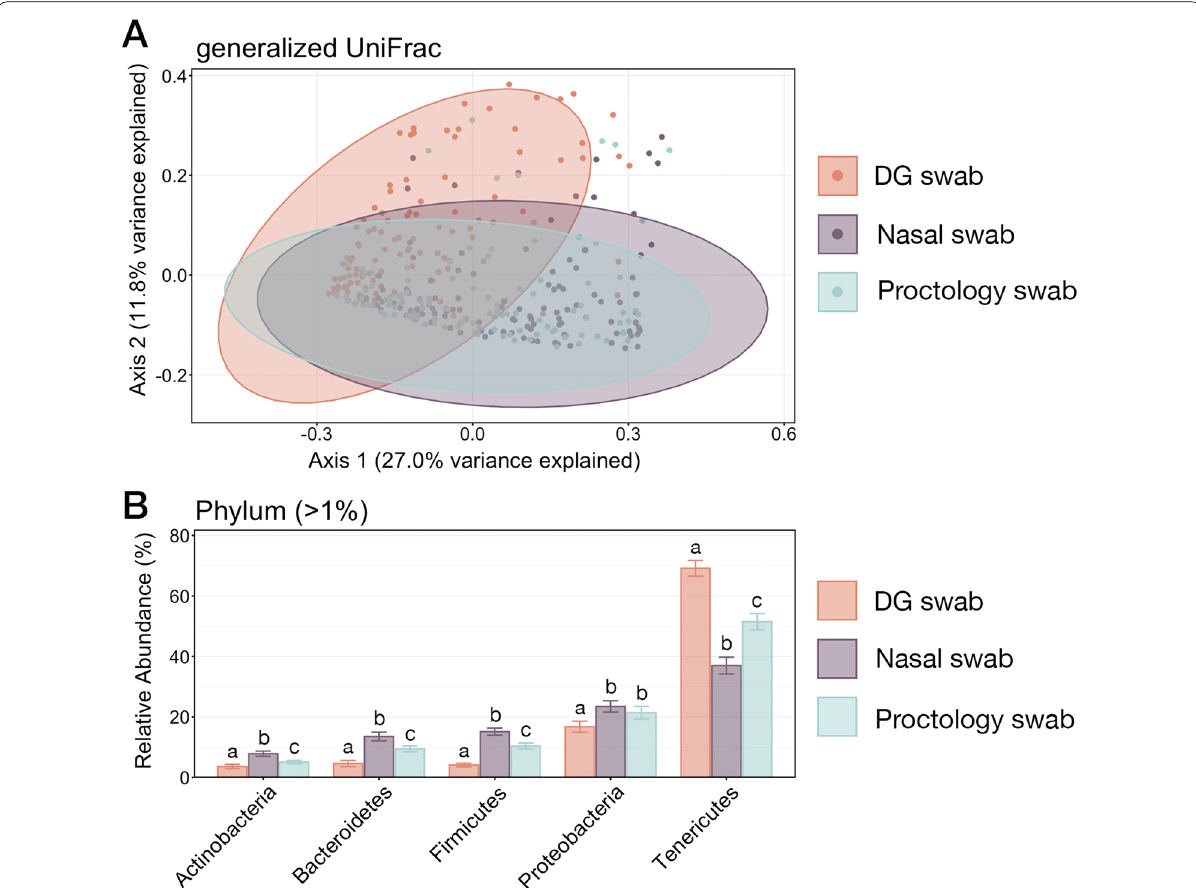
Fig. 6 A Principal coordinates analysis (PcoA) of generalized UniFrac values illustrating differences in microbial community composition between samples collected with each swab type. The PCoA demonstrates clustering of ASVs from microbial communities collected with DG swabs, NS, or PS. Shaded areas represent 95% confidence ellipses for each swab type. Microbial community composition differed significantly between each community type (pairwise PERMANOVA with Benajmin-Hochberg correction, P < 0.005). B Barplot showing the relative abundances of the six phyla representing greater than 1% of the whole community illustrating the variation in microbial community structure across all samples. Error bars on the barplot demonstrate the standard error of the mean relative abundance for each of the six phyla when sampled using DG swabs, NS, or PS. Significant differences between relative abundances as collected with each swab type are illustrated by different letters (Pairwise Wilcoxon rank-sum test with Benjamini–Hochberg correction, P <